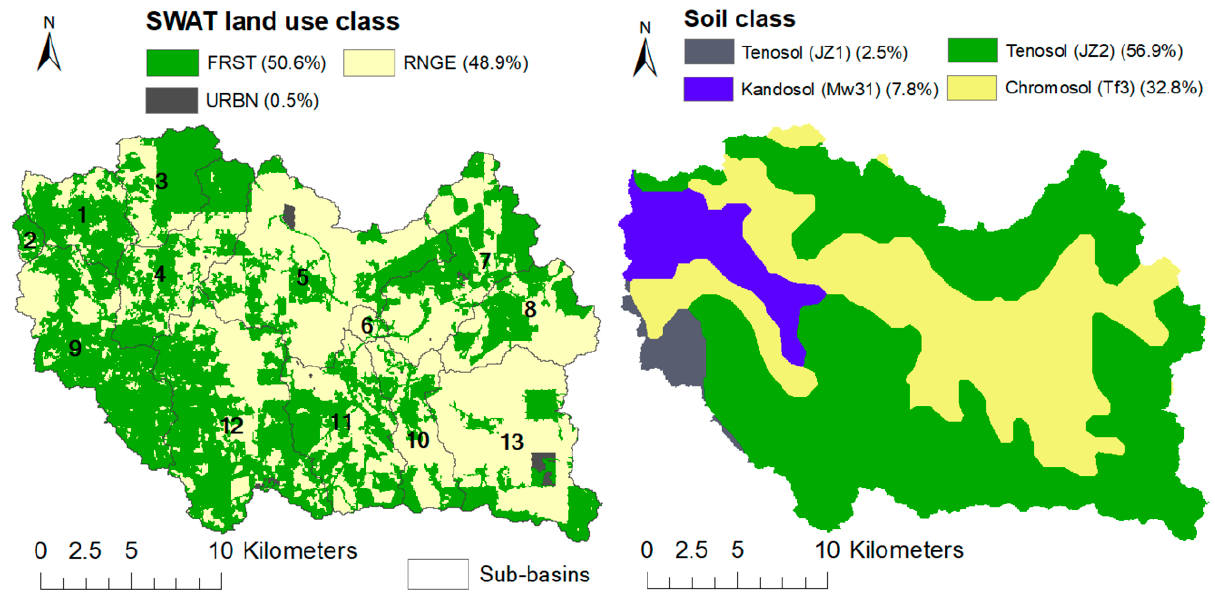
Figure 2. The maps of land use classification ( left ) and soil ( right ) in the SWAT model for the Woo- roloo Brook catchment (consists of 13 sub–basins),